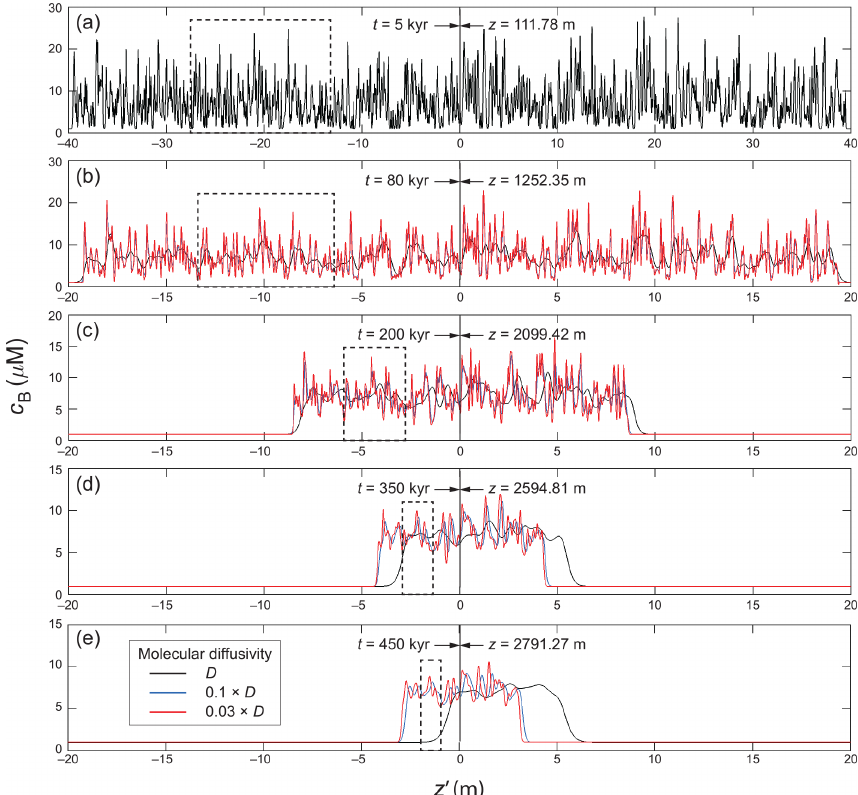
Figure 11. Simulated evolution of a long sequence of doped signals at the EPICA site, in three experiments assuming the molecular diffusiv- ities D (Table 1), 0 . 1 D , and 0 . 03 D . (a) Initial c B sequence. Used in all three runs and made from the superposition of 1200 decimetre-scale Gaussian peaks, it is not meant to recreate the actual signals at EPICA. (b) – (e) Snapshots of c B at later times. Labels near the vertical line indicate the depth and age of the ice at z (cid:48) = 0. The dashed boxes trace a group of signals as they evolve into new signals through compression– diffusion merging (Sect. 3.3). As D is reduced, signal persistence into deep ice improves, and signal displacement decreases. The duration of the signal sequence is ≈ 3600 yr in all panels. See Movie S5 for the full